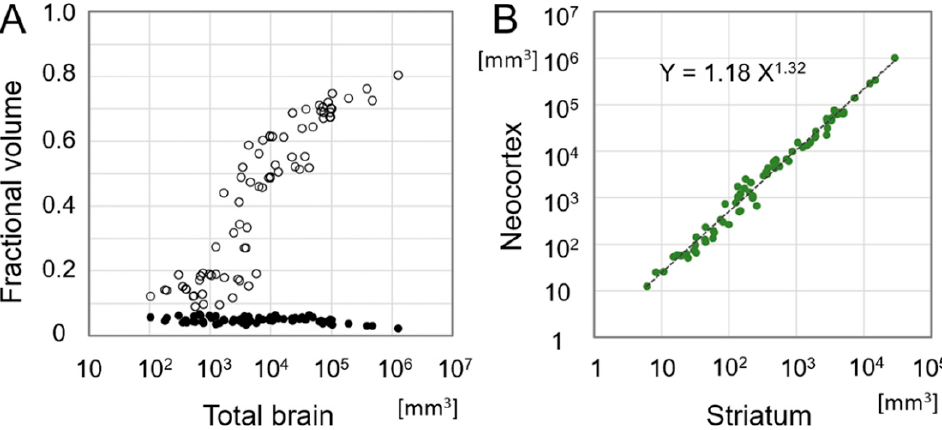
Figure 2. Evolutionary scaling relation between the striatum and neocortex. ( A ) A plot showing fractional volumes of the striatum (black dots) and the neocortex (open circles) in the total brain volume, which is defined as 1. The data are according to measurements of 76 species from insectivorous mammals to human [94]. Note that the striatal fraction is relatively constant throughout mammalian evolution whereas the neocortical fraction increased explosively. ( B ) A plot showing the volume of the neocortex as a function of the volume of the striatum according to the same data shown in ( A ). The best-fit exponential formula is: Y = 1.18X 1.32 , where X and Y are the volume of the striatum and the neocortex in cubic millimeters, respectively.